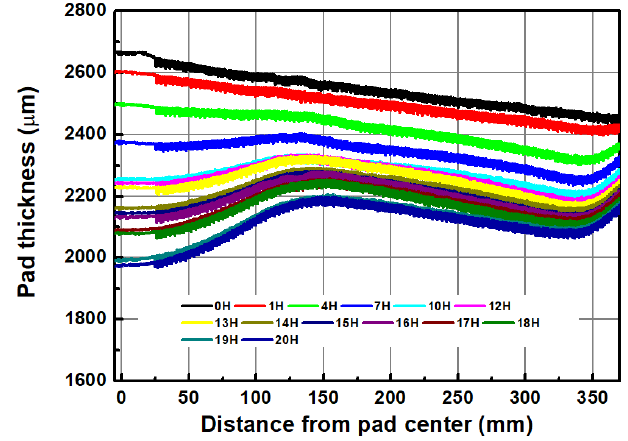
Figure 13. Pad thickness and profile change after conditioning for Case II.